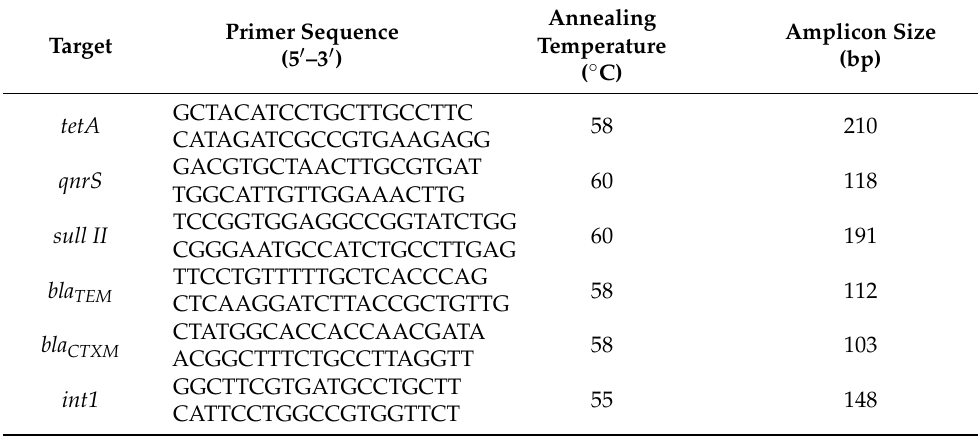
Table 1. Primers used in this study.